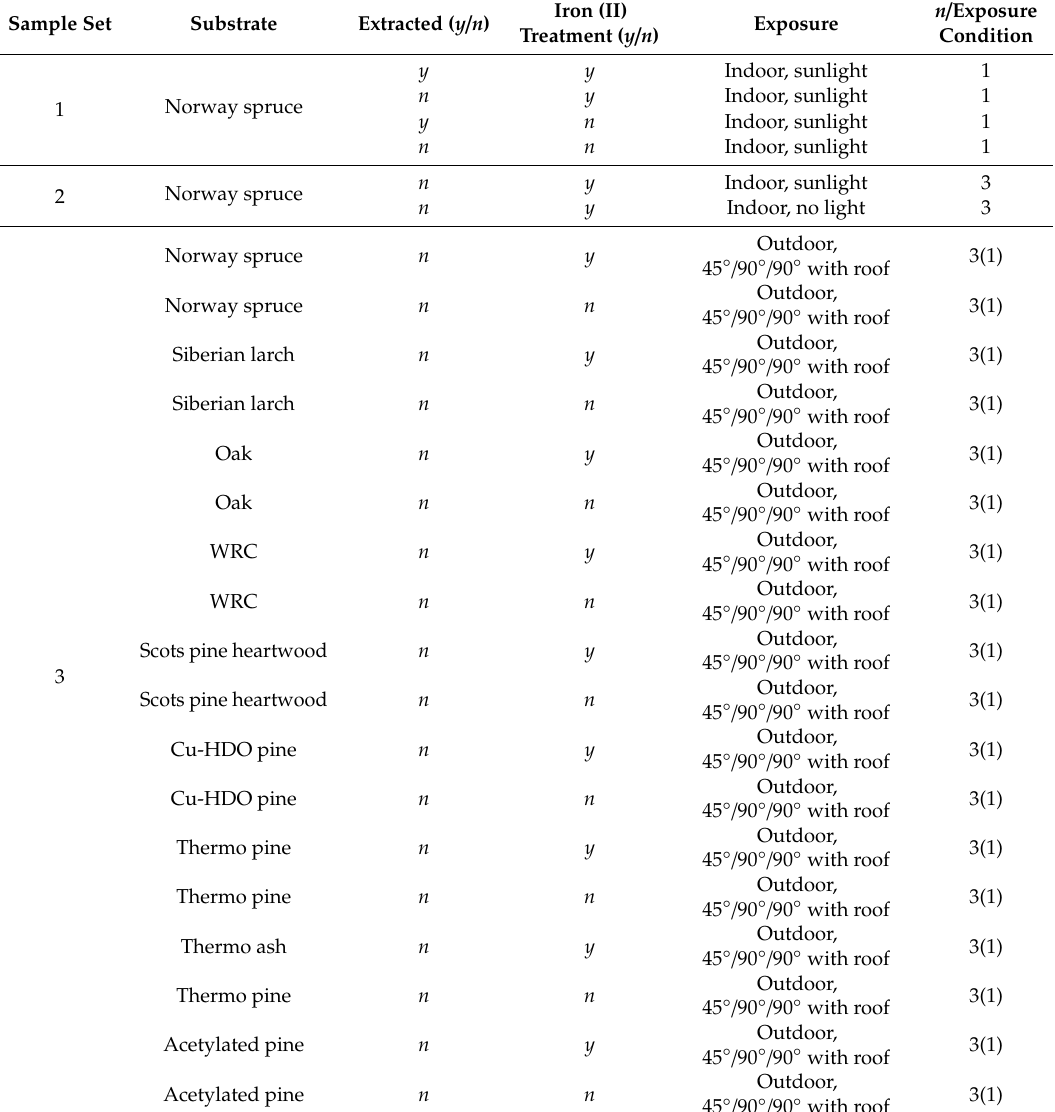
Table 1. Experimental design. Numbers in brackets indicate non-exposed